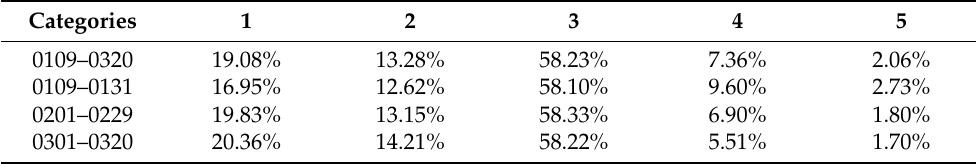
Table 4. The distribution of atmospheric stability at site 1.